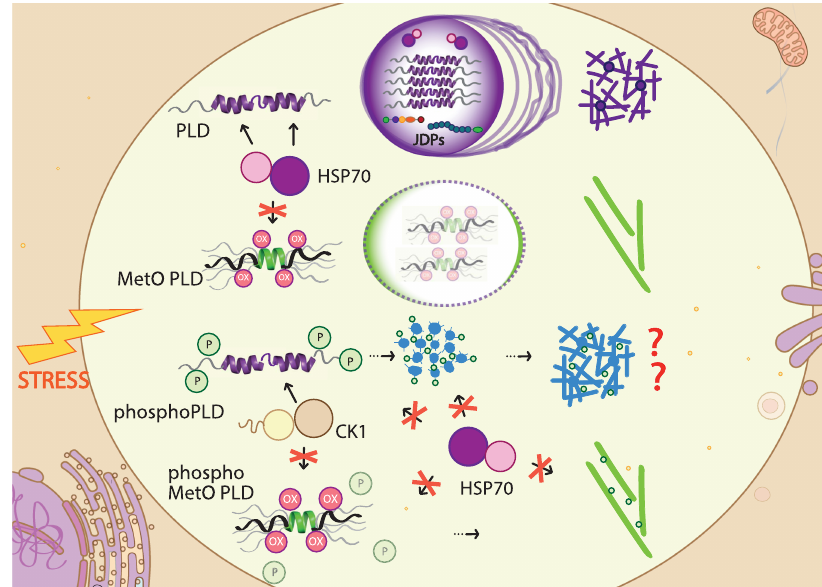
Fig.6|Mechanisticmodelfortheroleofthemodi fi cationsinthePLDinTDP-43 pathogenicity. TDP-43 PLD phase separation is strictly controlled by HSP70 and JDPs, whose interaction is mediated by structured elements present in the PLD. A liquid-to-solid transition will promote aggregate and fi bril formation. Under oxi- dative stress, methionine sulfoxidation ofthe PLD will promote structural changes that will abrogate chaperone control and impact PLD phase separation, leading to